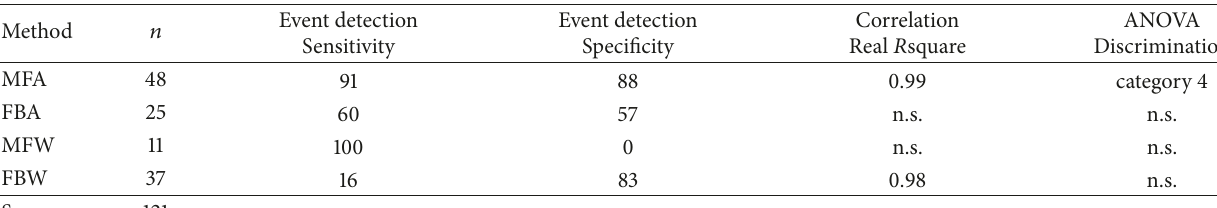
Table 1: Comparison of sensitivity and specificity of two different tracker devices (Misfit Shine and Fitbit flex) at two different locations (wrist and ankle). The fifth column (“Correlation Real 𝑅 square”) indicates the result of a regression analysis correlating the registered steps with real steps made (gold standard). The sixth column (“ANOVA Discrimination”) reports the results of an ANOVA regarding the discrimination of different activity categories by means of the indicated tracker configuration. MFA: Misfit Shine worn at the ankle, FBA: Fitbit flex worn at the ankle, MFW: Misfit Shine worn at the wrist, and FBW: Fitbit flex worn at the wrist.